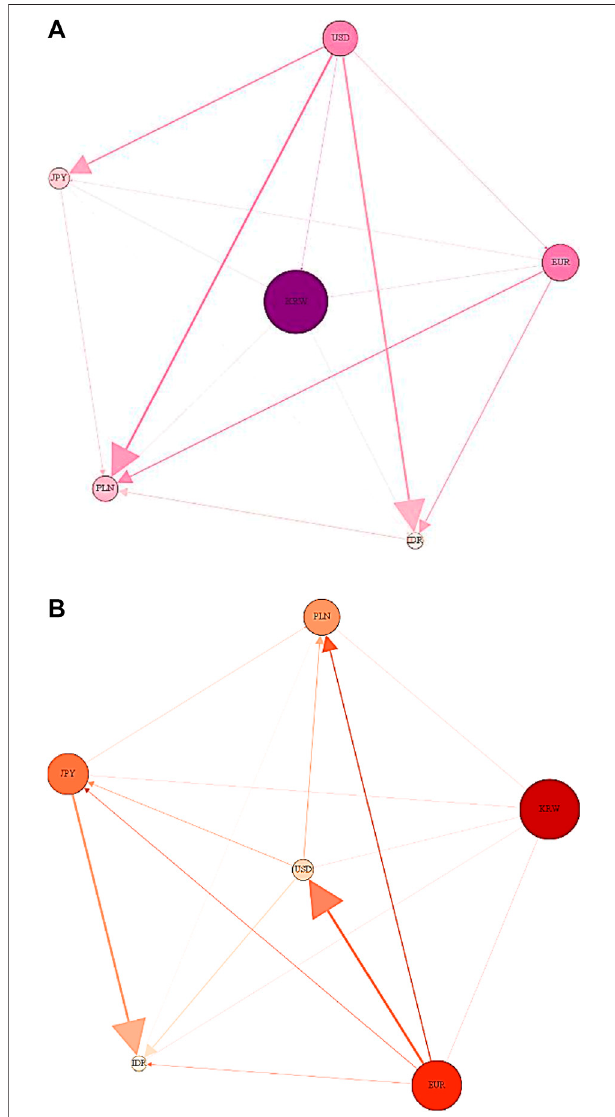
FIGURE3 | Net pairwise spilloverin good and volatility. Note: I.The lines between two nodes represent the net pairwise spillovers between two Bitcoin markets,whilethearrowsrepresentthespilloverdirection.II. (A) standsfornet pairwise spillover for good volatility, while (B) stands for bad volatility.